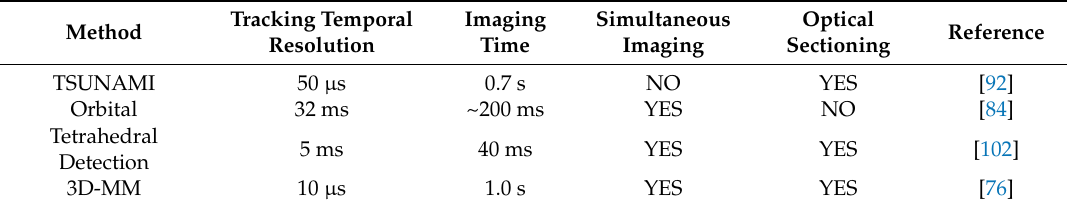
Table 2. Comparison of environmental contextualization metrics in active feedback RT-3D-SPT methods. Tracking temporal resolution derived from shortest integration time reported. Imaging time refers to the 2D frame time.